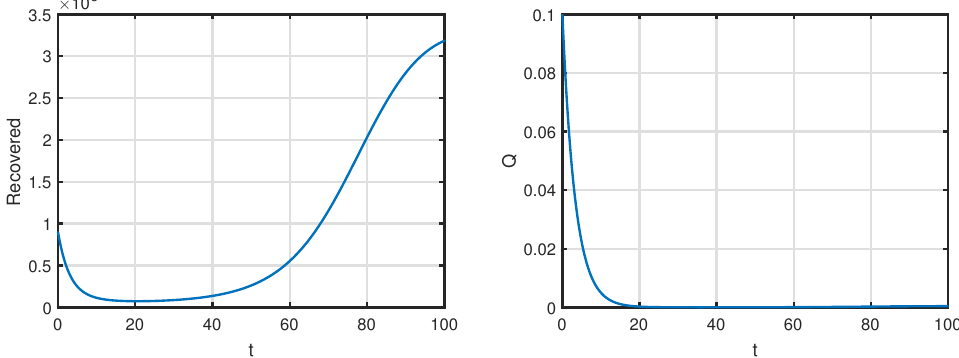
Figure 2. Time series of R , Q for 100 days from 1 January 2022 to 10 June 2022 when no government control is applied ( α =